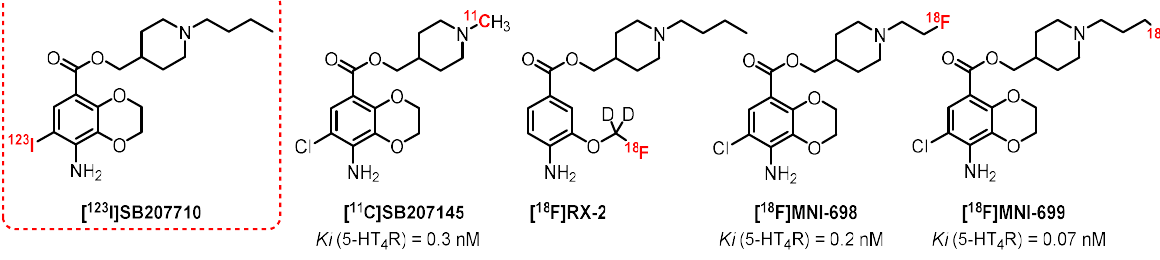
Figure 14. SB207710 derivatives as 5-HT 4 R radioligands.